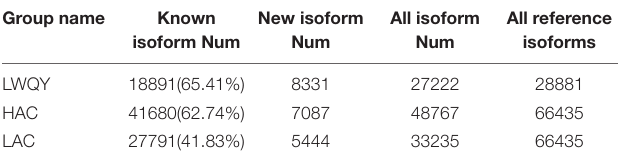
TABLE 1 | Number of transcripts found in the LWQY, HAC, and LAC groups.